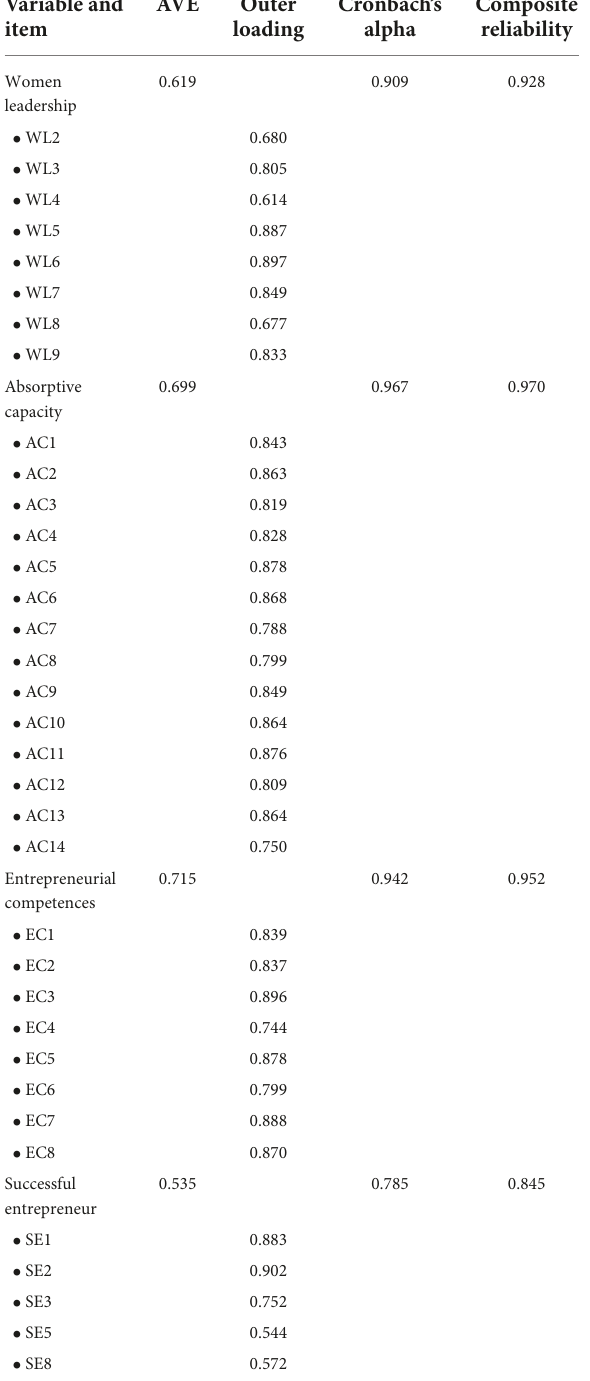
TABLE 2 Convergent validity and reliability (modification).